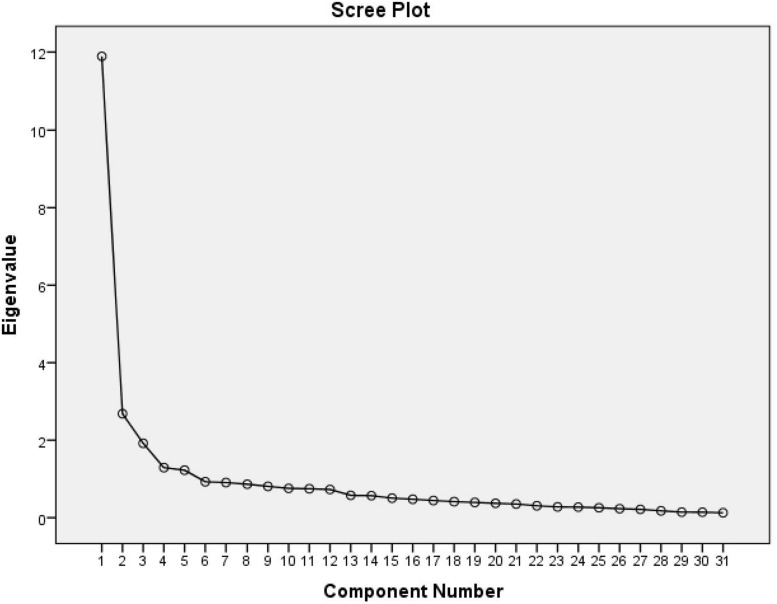
Scree plot of principal component analysis of the Relational Needs Satisfaction Scale.